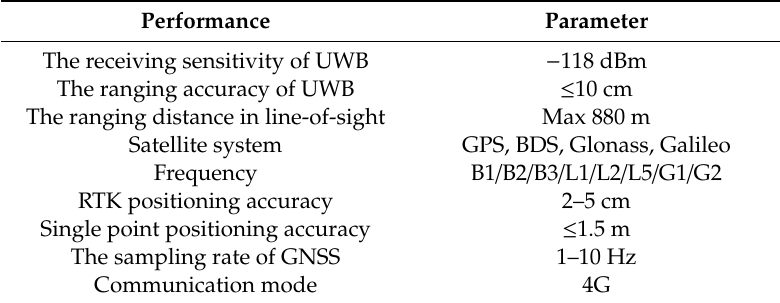
Table 1. Performance of GNSS / UWB seamless positioning base